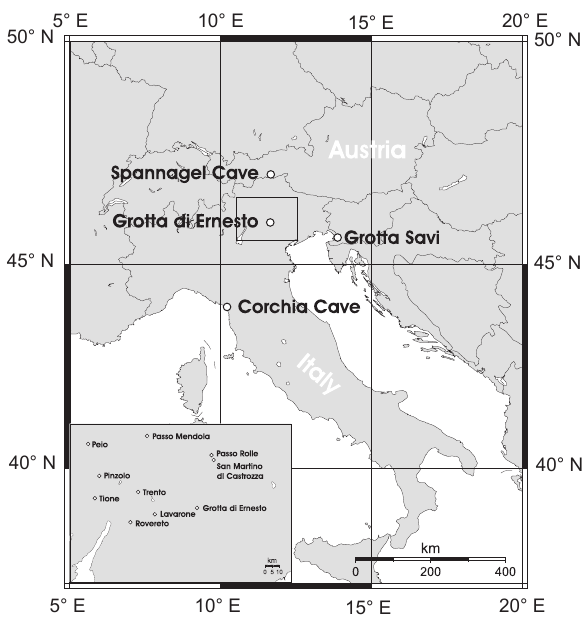
Fig. 1. Map showing the location of Grotta di Ernesto in north- eastern Italy south of the Alpine watershed. Also shown are the lo- cations of Spannagel cave (Austrian Alps), Savi Cave (near Trieste) and Corchia cave (Alpi Apuane, Italy). The rectangle denotes the position of the enlarged section, which shows the locations of the nine weather stations in Trentino used to quantify the influence of the NAO (see text for